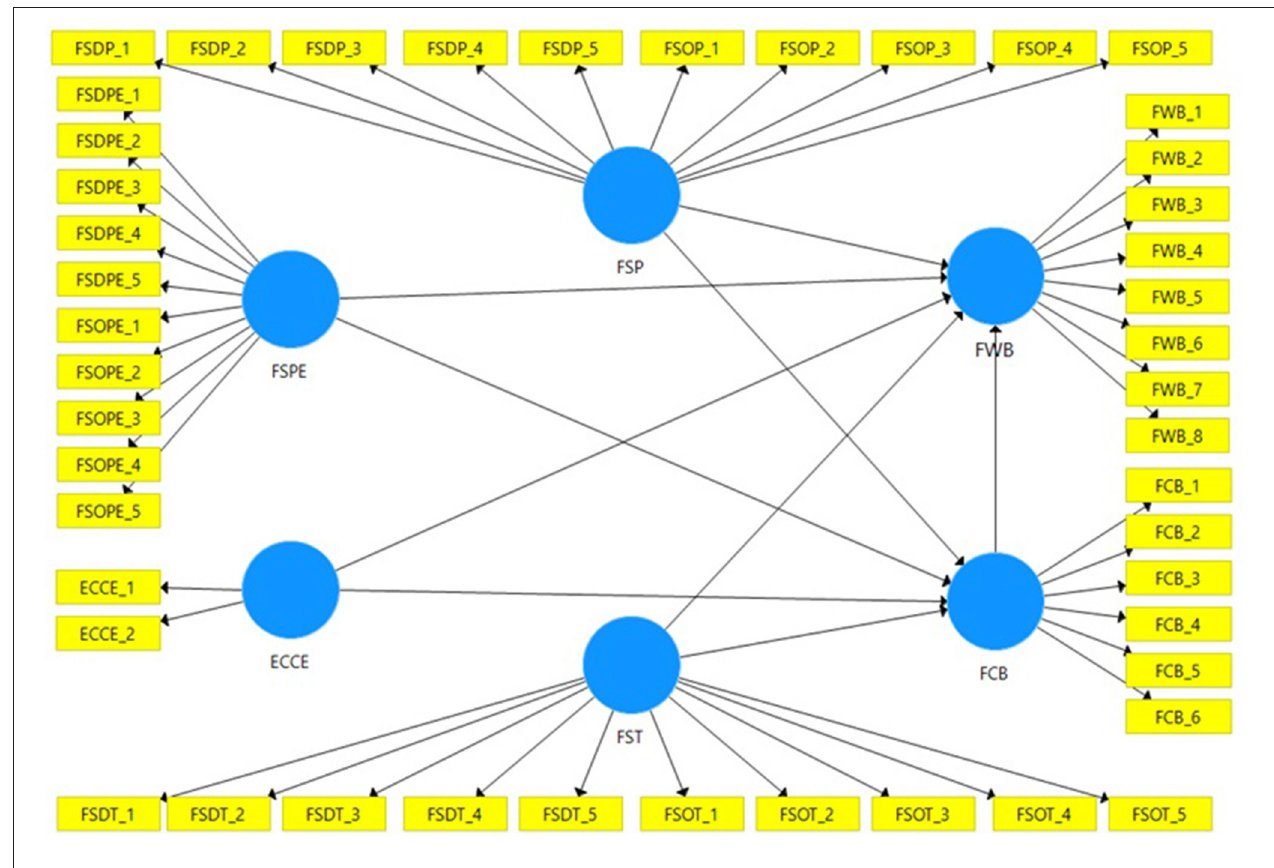
FIGURE 1 | Theoretical framework. Source: